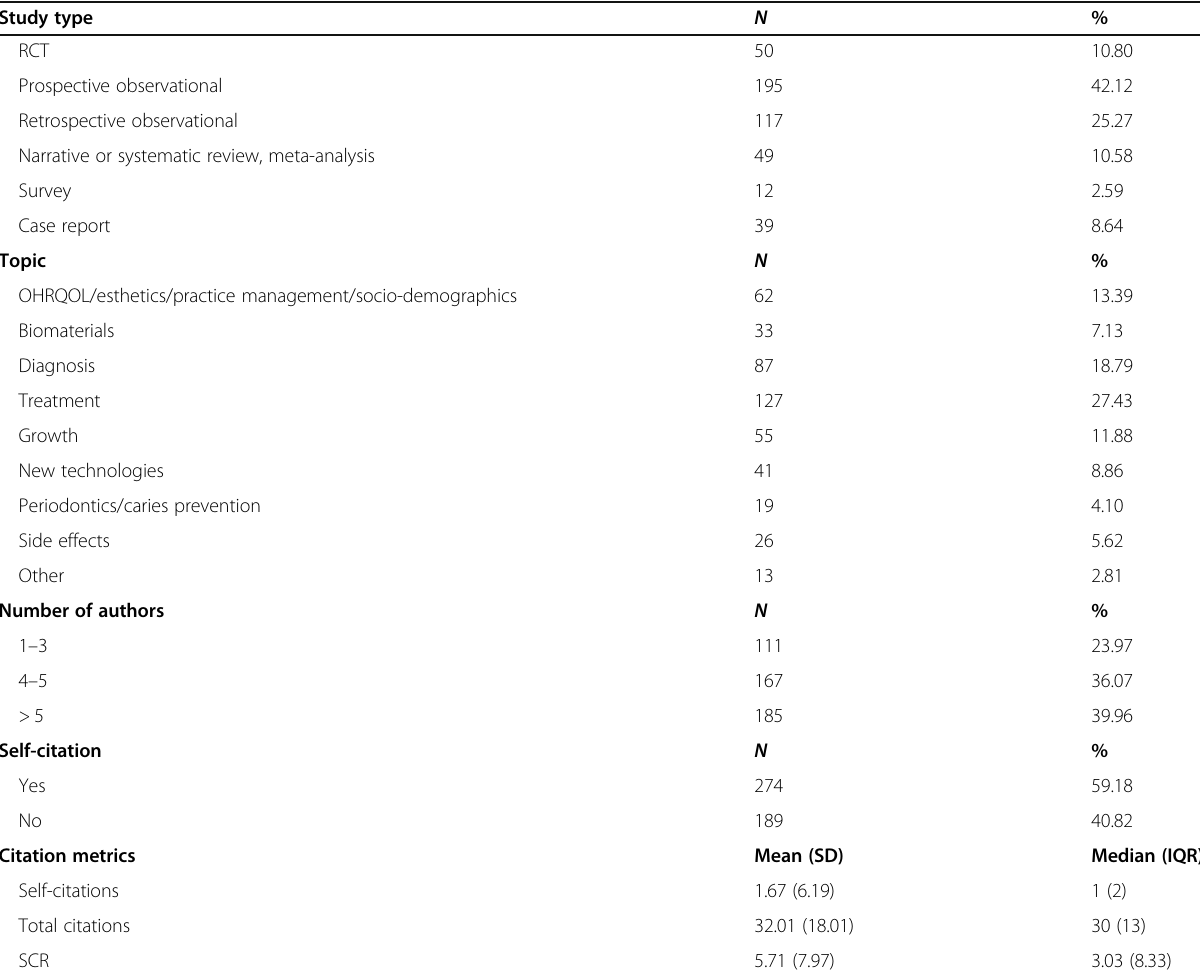
Table 1 Distribution of articles per study type, topic, number of authors, presence of self-citations, and descriptive statistics of citation